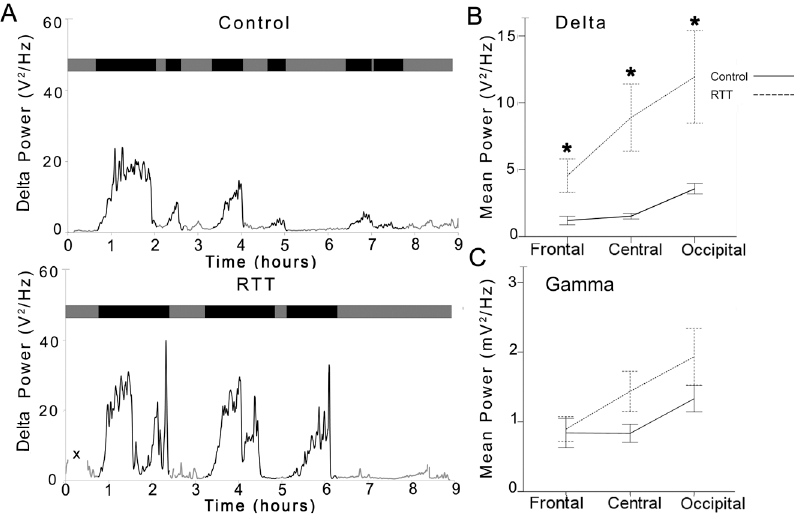
Fig 2. Comparison of control EEGs ’ and RTT EEGs ’ delta power. (A) Representative 8.5 hour EEG traces were scored as high delta power (black) and low delta power (grey). Comparison of RTT EEG with control EEGs revealed significantly higher delta power as well as fewer cycles. (B) RTT EEGs had significantly greater delta power in all three lead positions (frontal, central, occipital). (C) Patients with RTT had no significant difference in gamma power but revealed a trend of greater power reading in all three lead positions compared to control group.